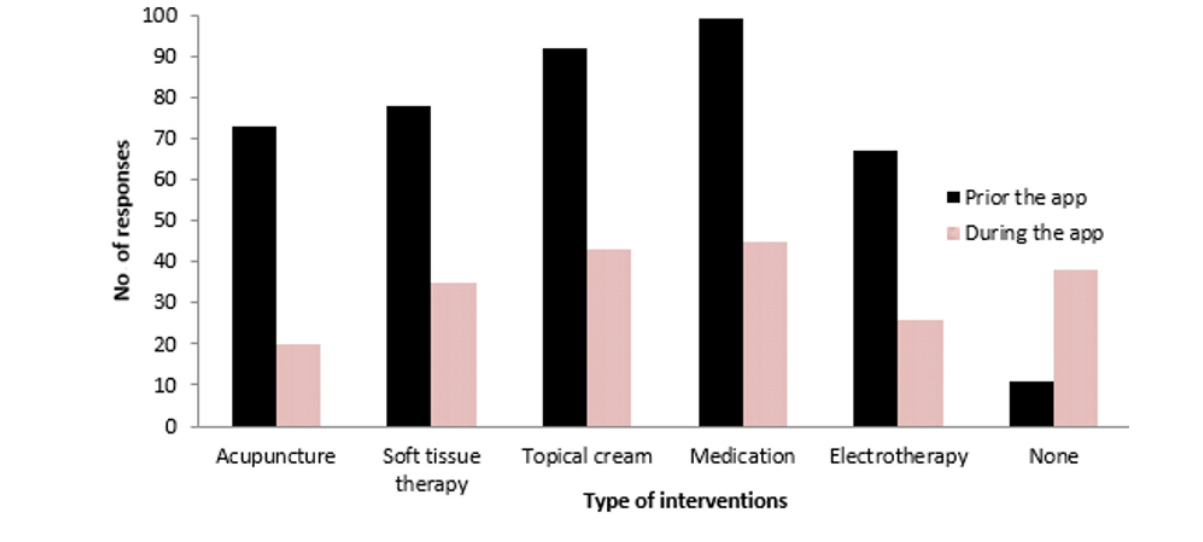
Figure 5. Bar graph to illustrate the number of responses of other interventions used prior to and when using the AI-embedded mobile